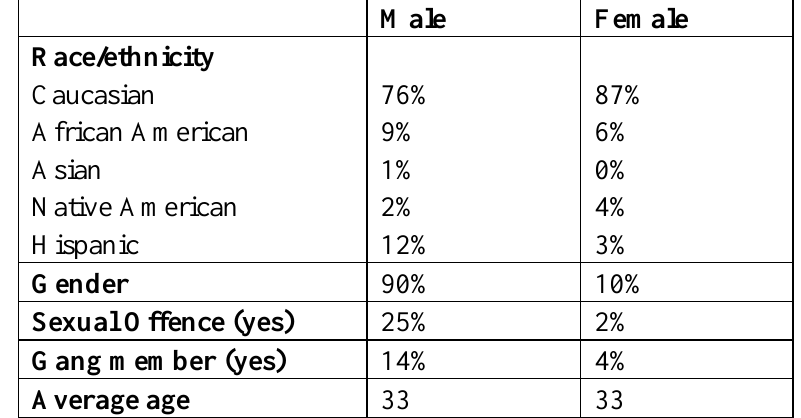
Table 1. Demographics of Study Population (N = 3009 males and 349